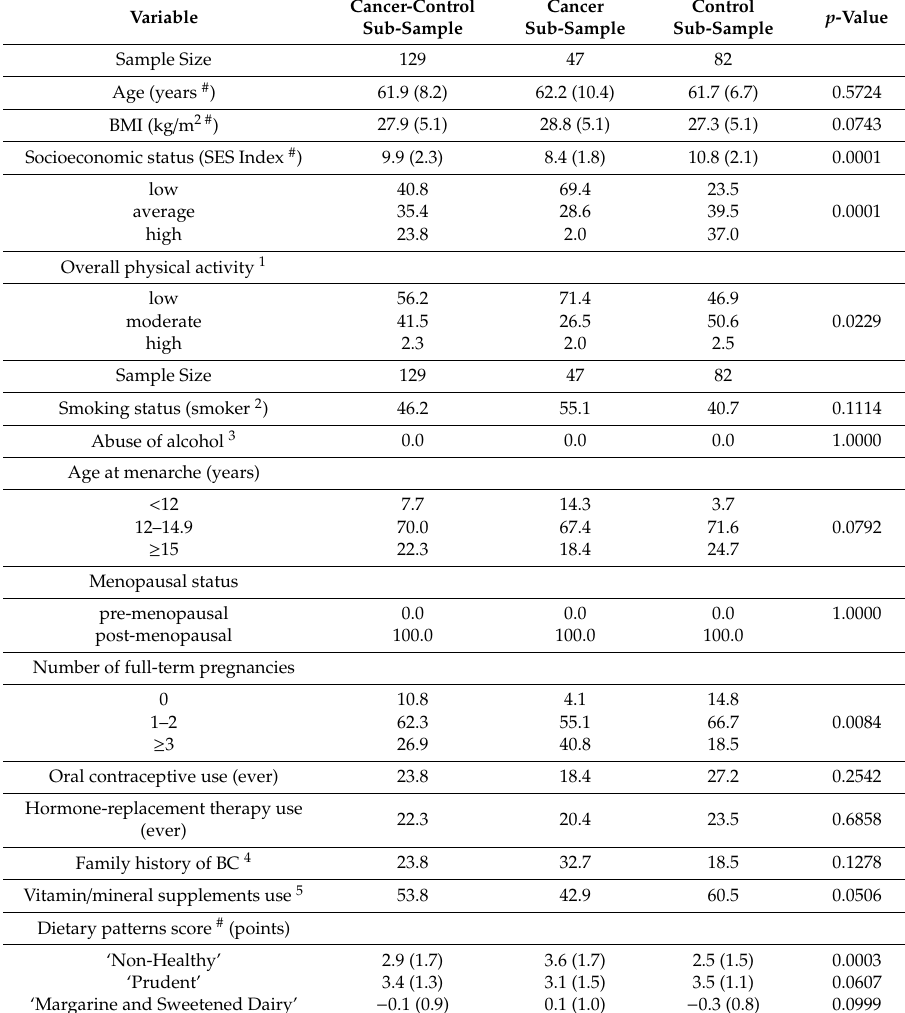
Table 7. Cancer-control sub-sample characteristics (% or